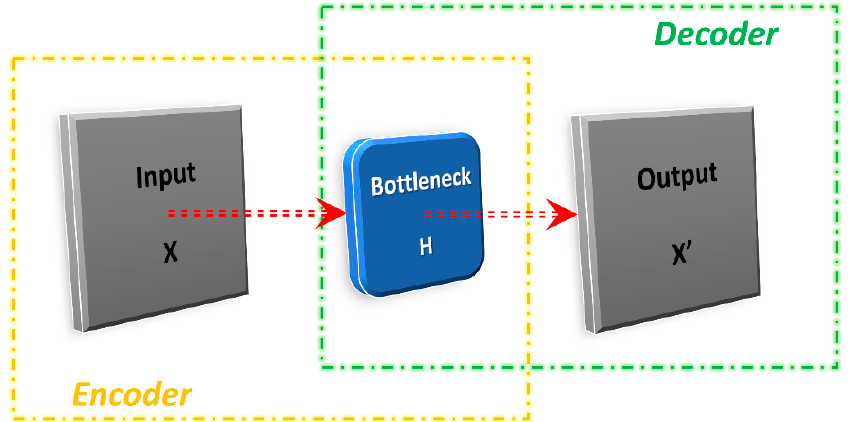
Figure 5. The bottleneck structure of an autoencoder. The first half is an encoder (yellow), which maps the input X to the bottleneck H; while the second half is a decoder (green), which maps the bottleneck H to the output X’. Firstly, the encoder processes X and generates H (containing important features); then, the decoder translates H into the desired output X’.